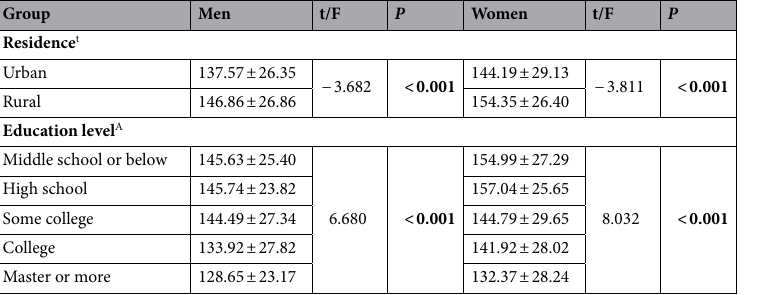
Table 4. Comparisons of FPI scores of different demographic characteristics subgroups (N = 508). t t-test. A ANOVA. Significant values are given in bold.